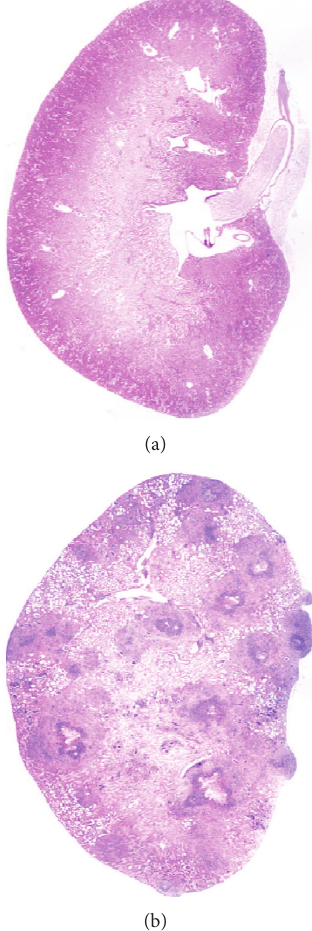
Figure 4: Histopathological changes in kidneys. Figure 4(a) was the control mouse showing no observed lesions. Figure 4(b) was the infected mouse presenting numerous granulomas in tissue section of the